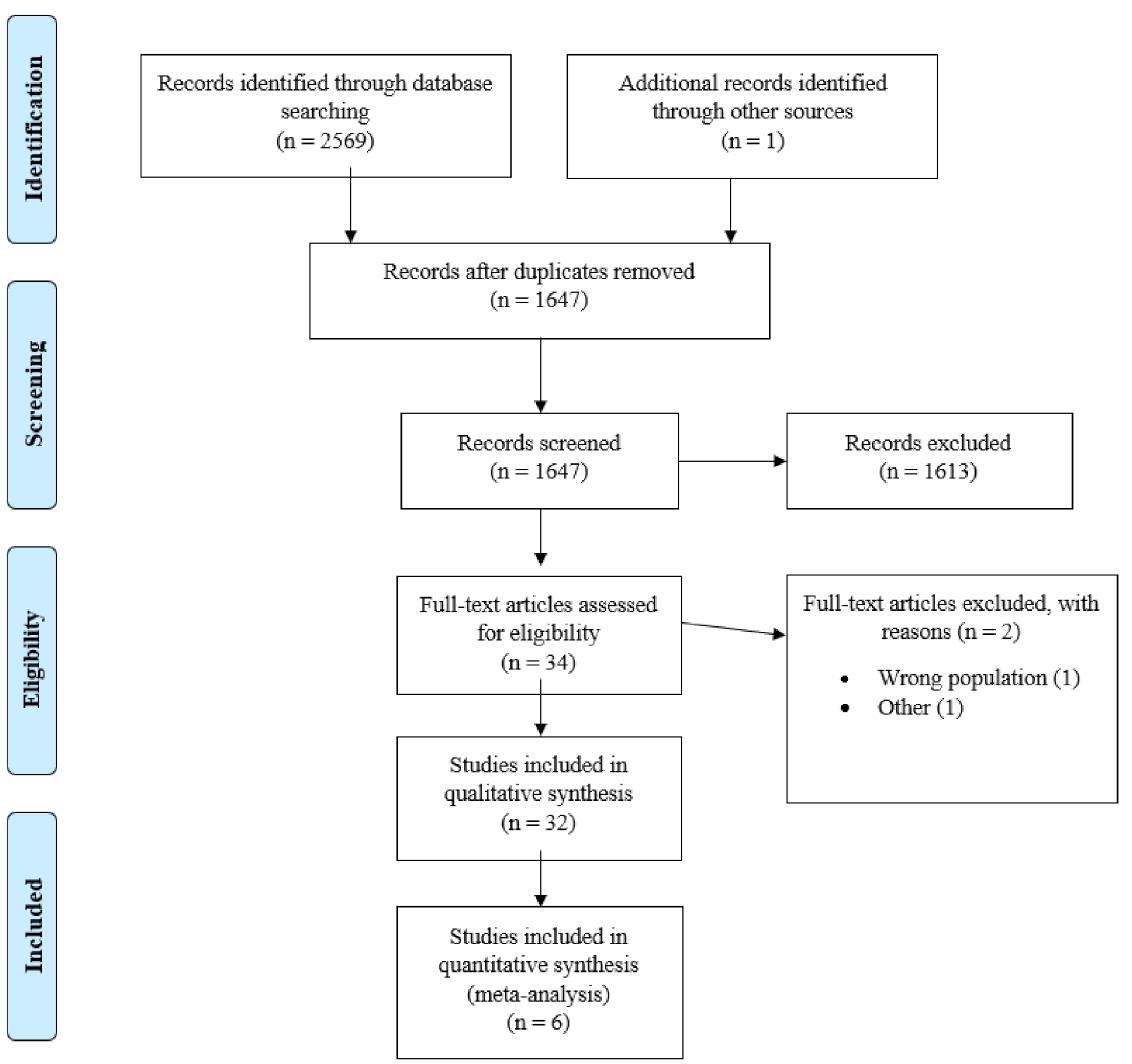
Figure 1. PRISMA